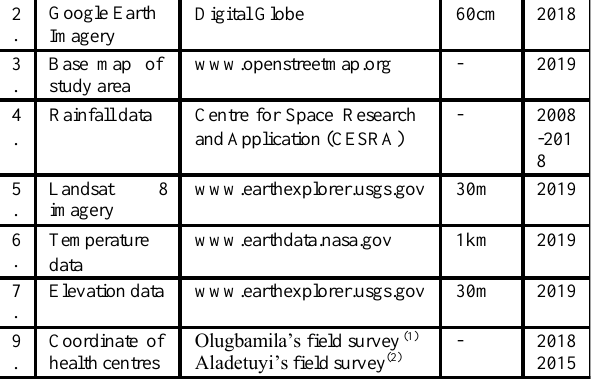
Table 2. List of secondary data